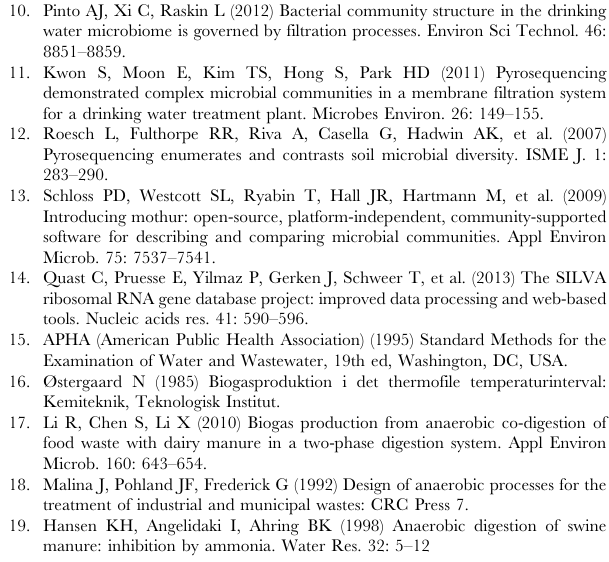
Figure S1 Rarefaction cures of bacterial (A) and archaeal (B) sequences from the fermentation reactors with different total solids contents. Table S1 Bacterial and archaeal richness and diversity indices for three reactors. All values were calculated at a distance level of 3%. Table S2 Taxonomic composition of bacterial commu- nities at the class level for the sequences retrieved from each samples. Table S3 Taxonomic composition of archaeal commu- nities at the genus level for the sequences retrieved from each